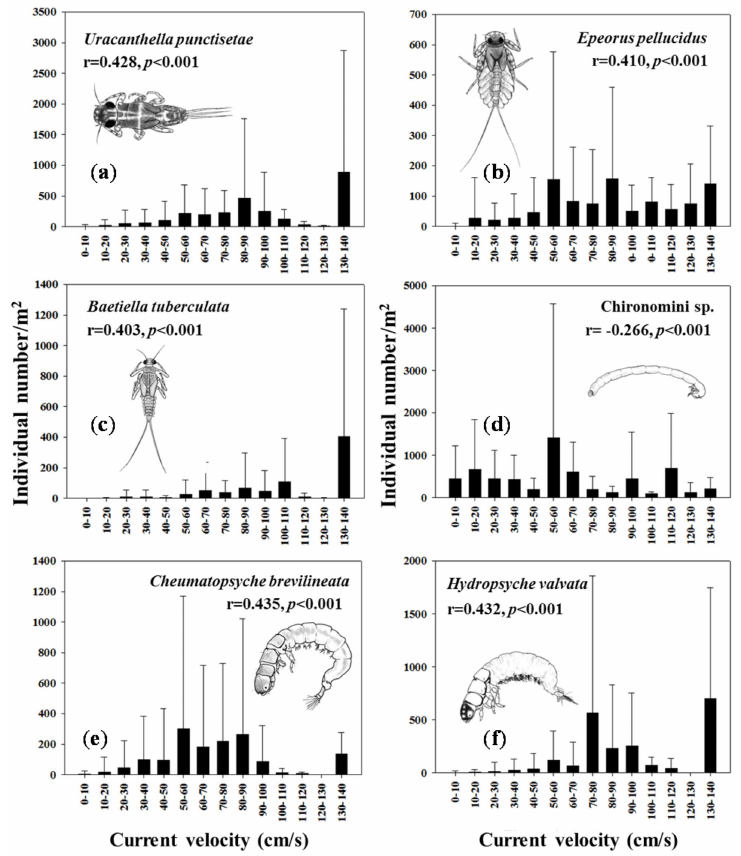
Figure 2. Distribution patterns of dominant macroinvertebrates along with water velocity. Data are given as arithmetic means with standard deviation. Spearman’s rank correlation coefficients between water velocity and abundance of each dominant species are included. ( a ) Uracanthella punctisetae ; ( b ) Epeorus pellucidus ; ( c ) Baetiella tuberculata ; ( d ) Chironomini sp.; ( e ) Cheumatopsyche brevilineata ; ( f ) Hydropsyche valvata